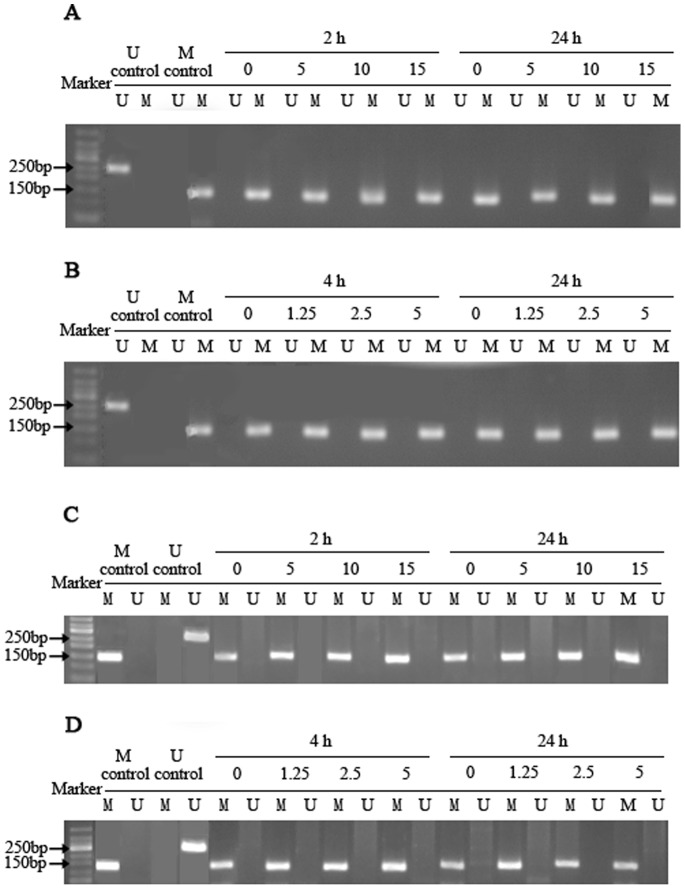
MSP analysis of p16 gene.Primer sets utilized for PCR amplification are designated as unmethylated (U) or methylated (M), and the amplification products were run on 3% agarose gel, stained with GelRed, and visualized under UV illumination. The methylated and unmethylated control DNA purchased from Qiagen company were used as a positive control for the methylated (M control) and unmethylated (U control) p16 gene, respectively. A and C: The results of MSP analysis of p16 gene in human B lymphoblastoid cells (A) and in A549 cells (C) treated with potassium dichromate at the concentrations of 0, 5 µM, 10 µM, and 15 µM for 2 hours and 24 hours. B and D: The results of MSP analysis of p16 gene in human B lymphoblastoid cells (B) and in A549 cells (D) treated with lead chromate at the concentrations of 0, 1.25 µg/cm2, 2.5 µg/cm2, and 5.0 µg/cm2 for 4 hours and 24 hours.